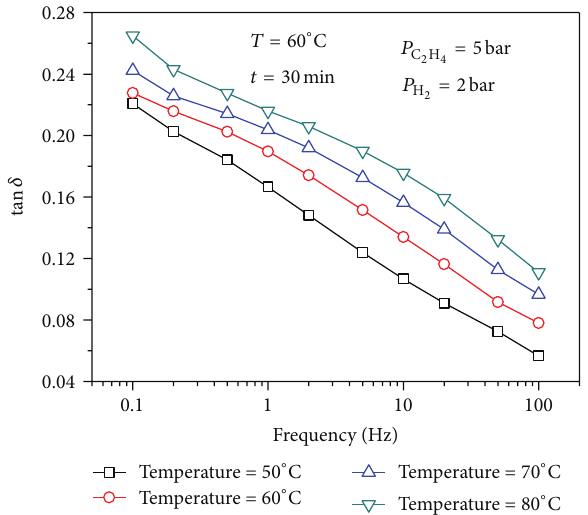
Figure 2: Dynamic temperature step/frequency sweep (tan 𝛿 ) for polyethylene sample 5 synthesized at 𝑃 𝑇 temperature = 60 ∘ C, and 𝑡 polymerization